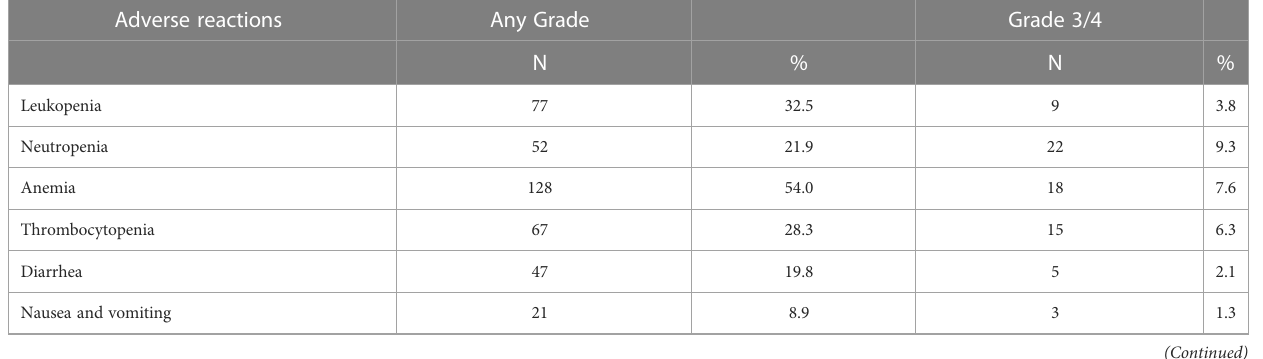
TABLE 6 Adverse events of imatinib in patients with CML. Adverse